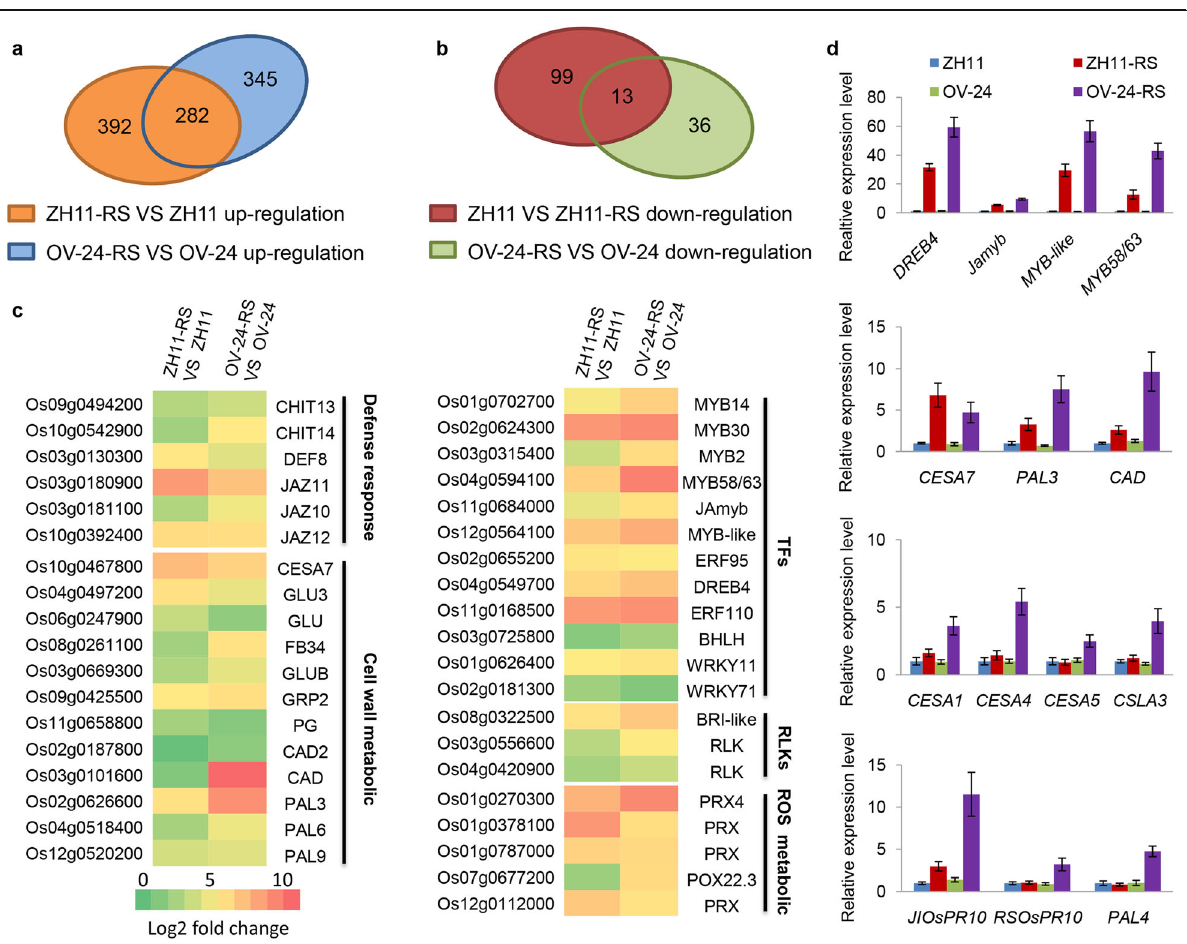
Fig. 5 RNA-seq analysis of differentially expressed genes between the OsPGIP1- overexpressing line (OV-24) and ZH11 in response to RS105 inoculation. a and b Venn diagram of upregulated ( a ) or downregulated ( b ) DEGs in response to RS105 at 24 h postinoculation. DEGs were considered at P value< 0.001 and |log2-fold change| > 1. ZH11-RS vs. ZH11 and OV-24-RS vs. OV-24 represent the common DEGs identified in two experimental repeats, with noninfected ZH11 and OV-24 as controls. c Heatmap analysis of the common significantly upregulated DEGs in OV-24- RS vs. OV-24 and ZH11-RS vs. ZH11. The heatmap was classified into defense response, cell wall metabolism, transcription factors (TFs), receptor- like kinases (RLKs) and ROS metabolism. The intensity of color indicates the expression level of genes from left to right, indicating higher gene expression. d The expression of the transcription factor genes, cell wall-related genes and defense response genes that were upregulated in RNA- seq analysis was evaluated by qRT-PCR in ZH11 and OV-24. The internal control gene was ACTIN. The above experiments were repeated three times with similar